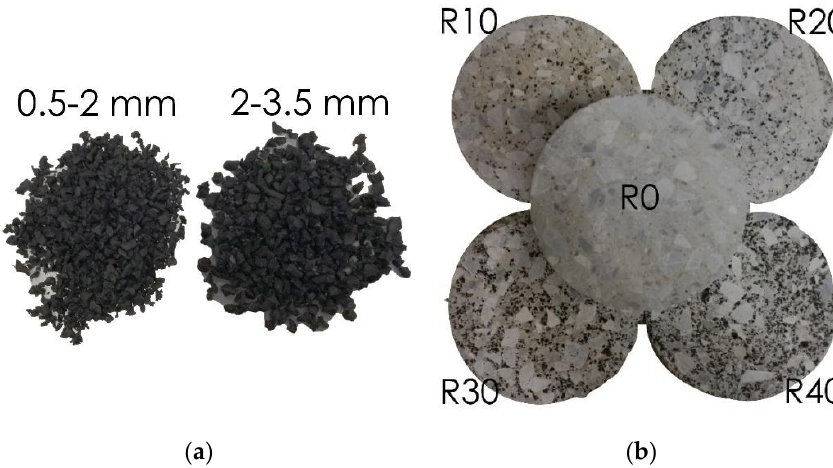
Figure 3. ( a ) Particles of recycled rubber aggregate used in concrete mixes; ( b ) crosssections of cylindrical specimens for different percentages of rubberized aggregate.